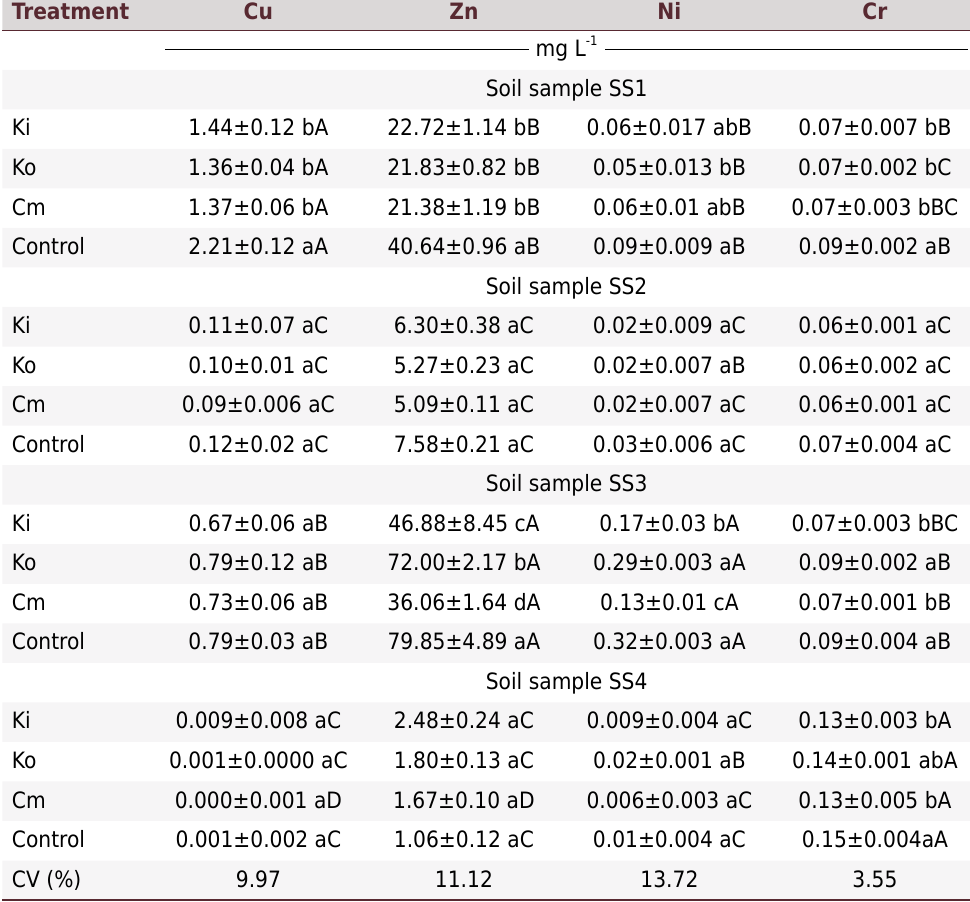
Table 3. Metal concentration available in soil samples after application of bacterial inoculum Treatment Cu Zn